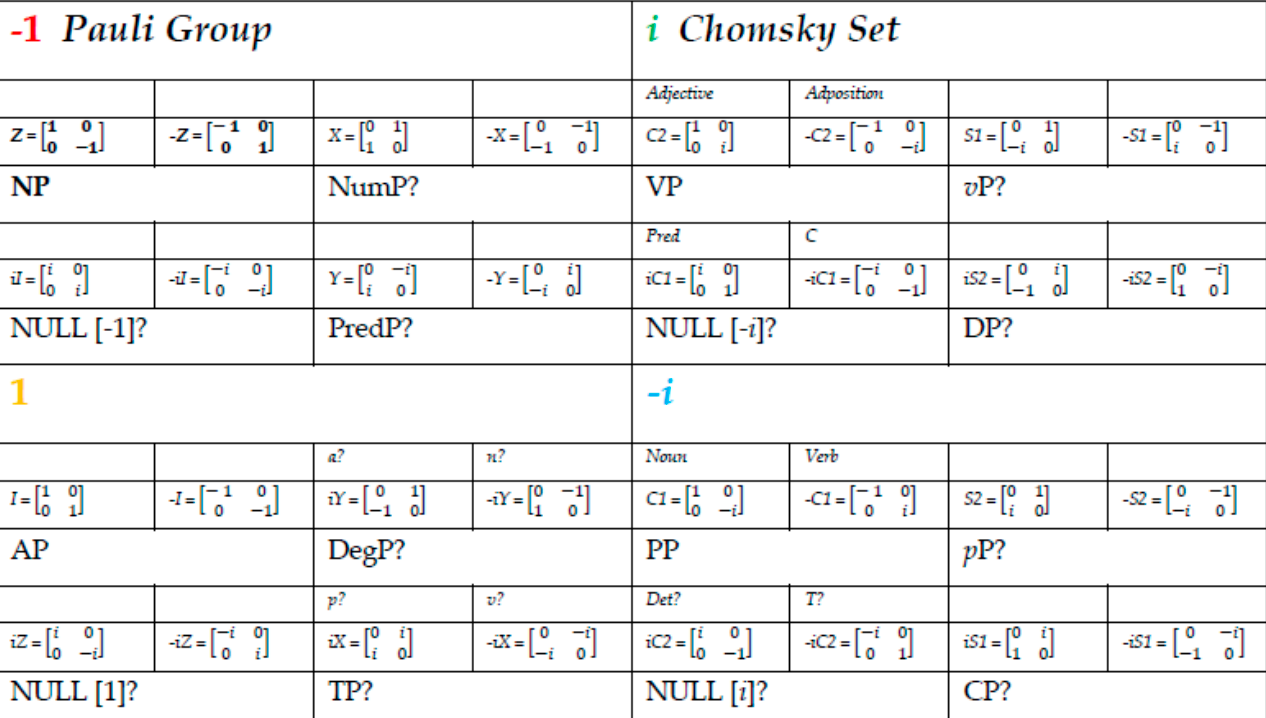
Figure 2. A (tentative) version of the SJG.